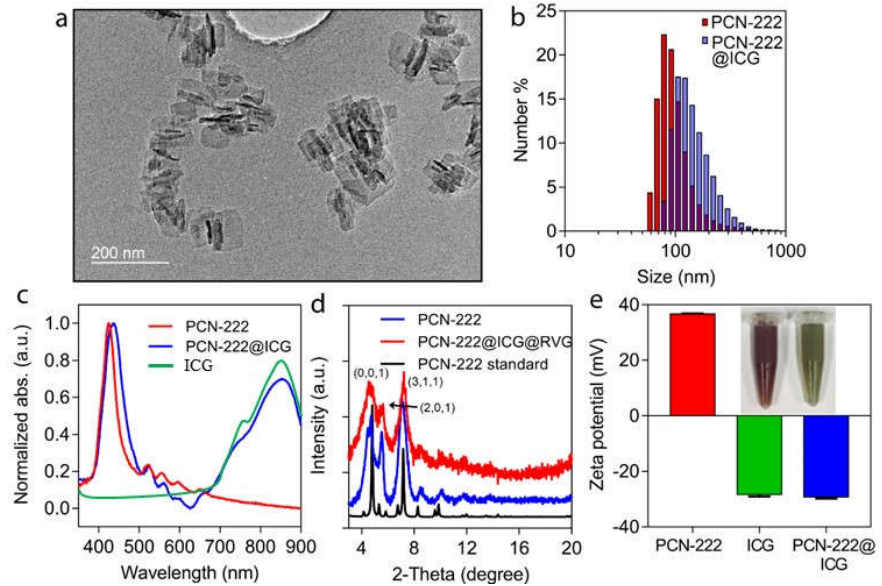
Figure 1. Characterization of PCN−222@ICG nanosystem. ( a ) TEM image of PCN−222@ICG nanosheet. ( b ) DLS size of PCN−222 and PCN−222@ICG. ( c ) UV-vis spectra of PCN−222 and PCN−222@ICG. ( d ) Powder XRD spectra of PCN−222 and PCN−222@ICG. Three obvious peaks can be assigned to (0, 0, 1), (2, 0, 1), and (3, 1, 1). ( e ) Zeta potential of PCN−222, free ICG, and PCN−222@ICG. Inset is a photograph of PCN−222 before (left) and after (right) coupling with ICG. Each measurement was conducted three times.